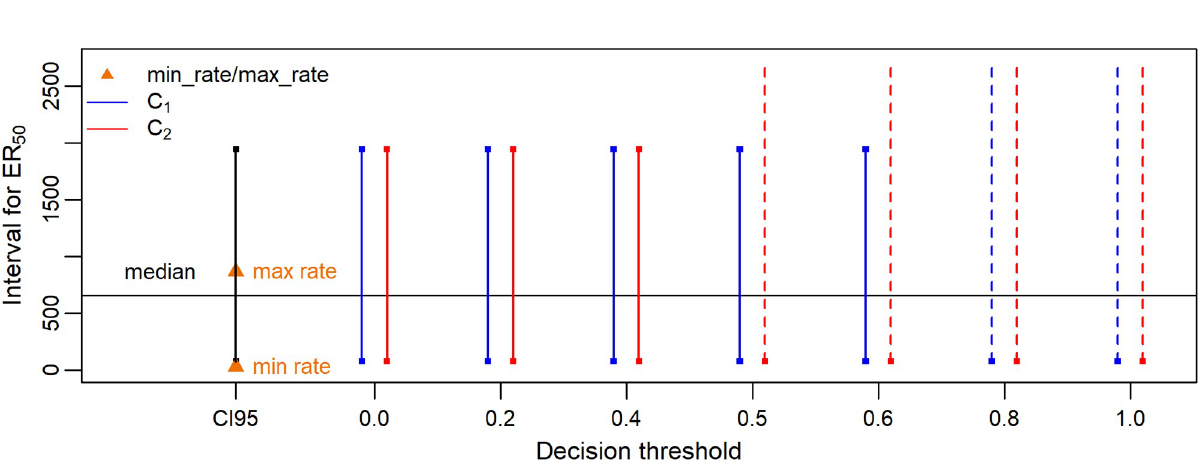
Fig 3. Censored ER 50 according to both criteria and the seven decision thresholds for the shoot dry weight endpoint of the VV test from case study 1—species ALLCE. The two orange triangles stand for the lowest and the highest tested rates. Vertical segments of three different colours (black, blue, red) represent the CI 95 of ER 50 , the censored ER 50 according to C 1 and the censored ER 50 according to C 2 , respectively; solid vertical segments are for bounded intervals while dotted vertical segments stand for right-unbounded intervals; the black horizontal line represents the median of the ER 50